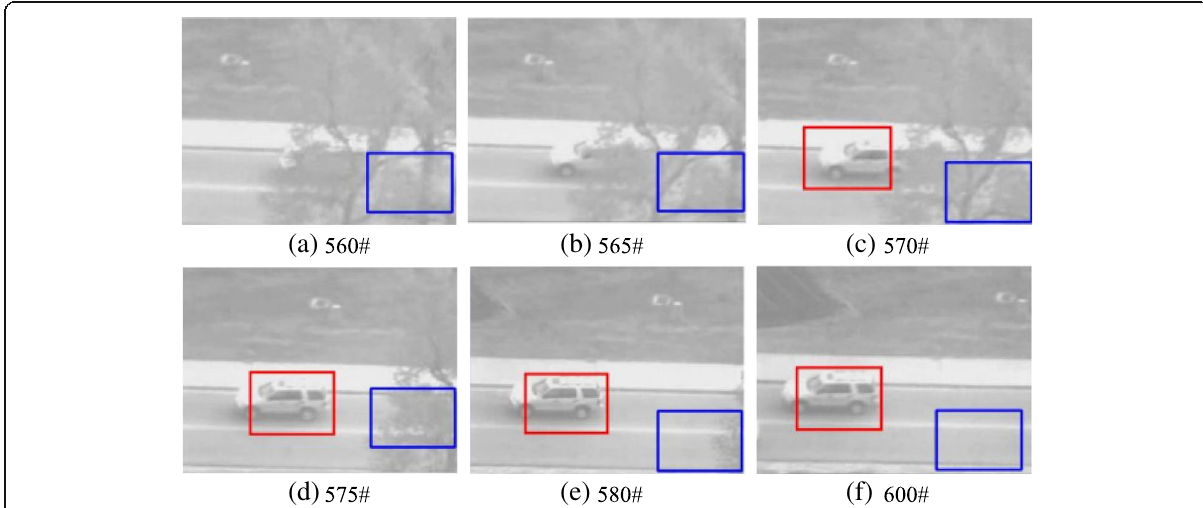
Fig. 14 Tracking results of the partial car video. a , b , c , d , e and f represent 560th frame, 565th frame, 570th frame, 575th frame, 580th frame and 600th frame, respectively